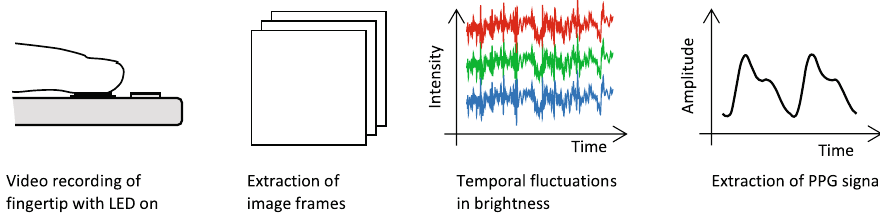
Fig. 2 Construction of the PPG signal from fi nger-based video recording. After the video is recorded, a mean pixel brightness for each color channel (red, green, and blue) is computed over the entire frame. This results in a signal that re fl ects the temporal fl uctuations in brightness for each color channel. Subsequently, a single-color channel (mostly green or red) is typically band-pass fi ltered to obtain the desired photoplethysmographic (PPG) signal. This schematic represents the general work fl ow and highlights commonalities among the different